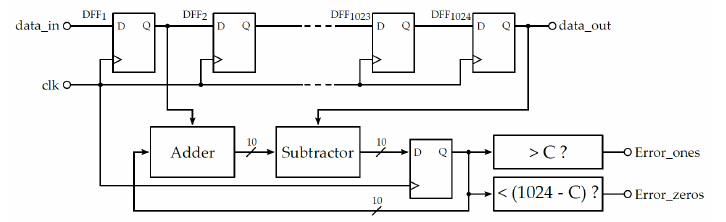
Figure 15. Hardware implementation of the adaptive proportion test for a binary random